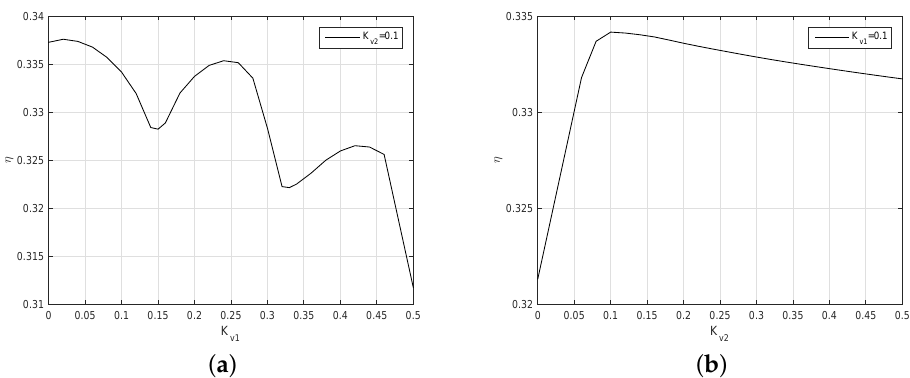
Figure 18. The efficiency of the robotic fish to K v 1 and K v 2 . ( a ) The changing of efficiency along with the variation of K v 1 when K v 2 = 0.1; ( b ) The changing of efficiency along with the variation of K v 2 when K v 1 =